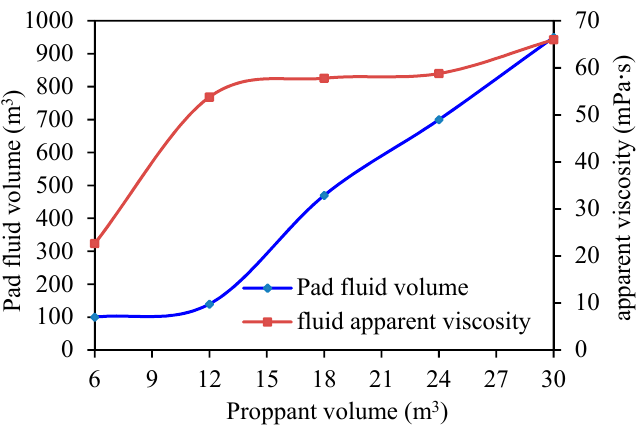
Figure 21. Optimized pad fluid volume and fluid’s apparent viscosity vs. injected proppant volume.